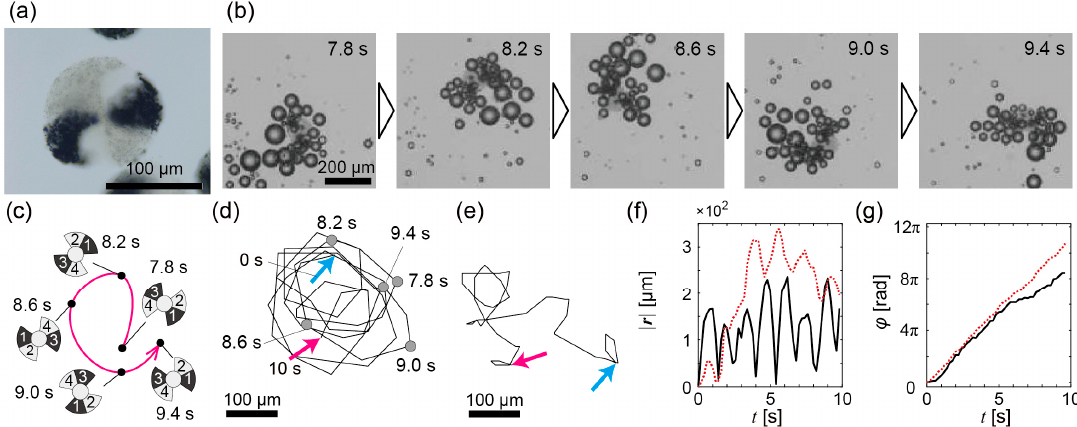
Figure 3. Experimental results of bubble propulsion of the propeller-shaped micromotors with double catalytic sites in the H 2 O 2 solution. ( a ) A microscope image of a propeller-shaped micromotor with double catalytic sites; ( b ) Time series from t = 7.8 s to t = 9.4 s of a propeller-shaped micromotor with double catalytic sites propelled by bubbles; ( c ) Schematic illustration of the trajectory of ( b ); ( d ) The whole trajectory of the micromotor in ( b ); Cyan arrow: t = 0 s; magenta arrow: t = 10 s; ( e ) Trajectory of another micromotor. The notation of arrows is the same as in ( d ); ( f ) The time variation of | r ( t )|. Black solid line: For trajectory of ( d ); red dashed line: For trajectory of ( e ); ( g ) The time variation of ϕ ( t ) . The notation of each line is the same as in ( f ).